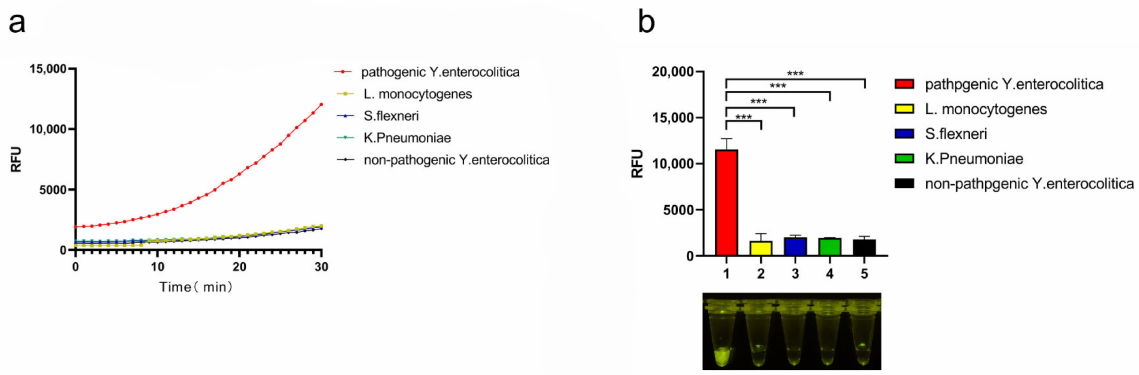
Figure 3. The specificity of Cas12a/crRNA direct cleavage assay: ( a ) Cas12a/crRNA assay specificity towards five different bacteria (pathogenic Y. enterocolitica, Listeria monotygenes, Klebsiella pneumoniae , Shigella flexneri , non-pathogenic Y. enterocolitica ). Kinetics for five bacteria are shown. ( b ) Cas12a/ crRNA assay sensitivity analysis. Endpoint fluorescence and visualization of targets are shown. n = 3 for biological replicates, * p < 0.05, ** p < 0.01, *** p < 0.001, and **** p < 0.0001, NTC—non-target control, error bars represent mean ±